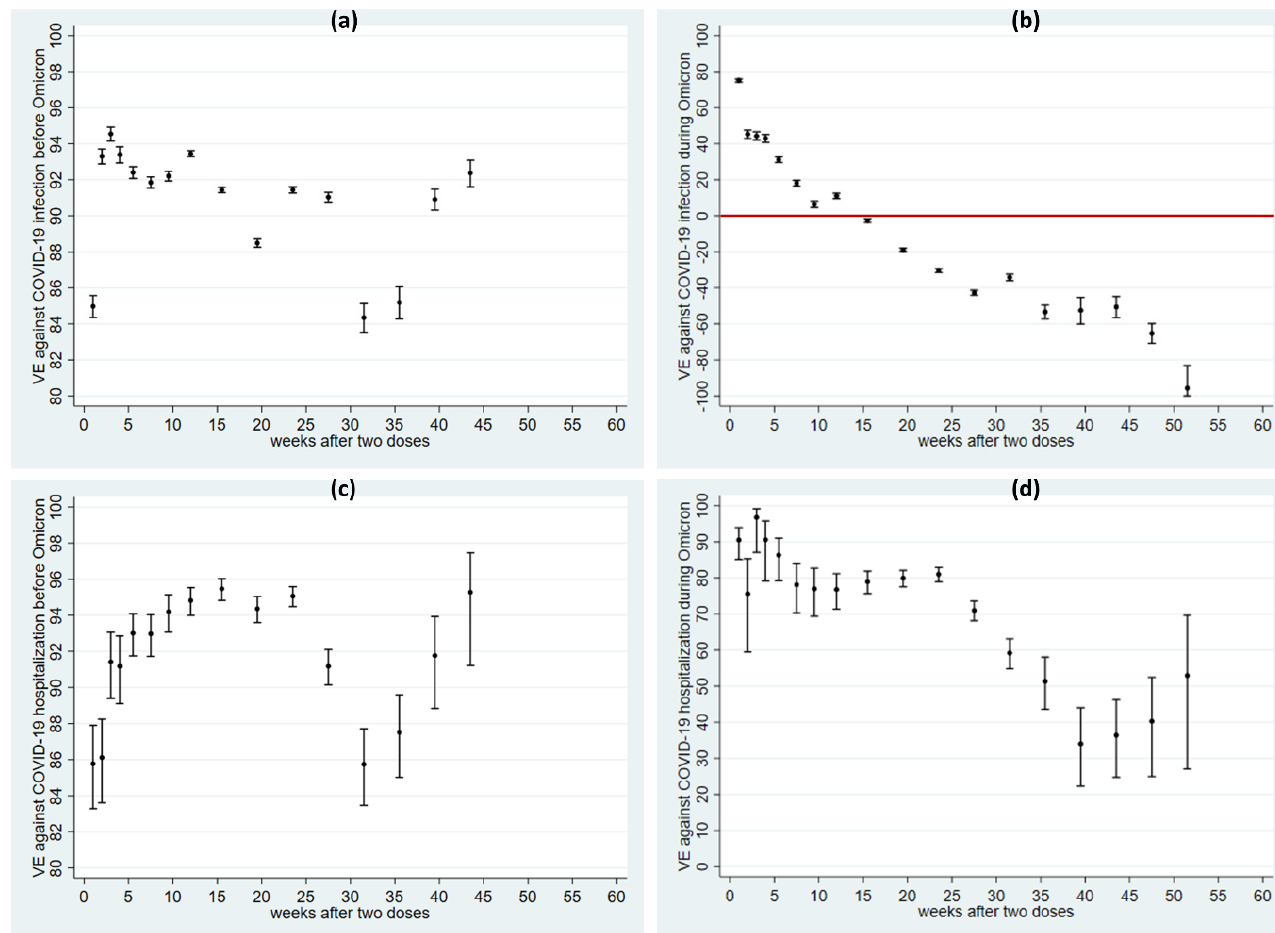
Figure 3. Adjusted vaccine effectiveness (dots) with 95% CI (capped spikes) of vaccine effectiveness before and after Omicron against COVID-19 infection ( a , b ) and COVID-19 hospitalization ( c , d ). Note that the y-axis scales are quite different. Legend: VE denotes vaccine effectiveness. The red line in ( b ) indicates VE = 0.